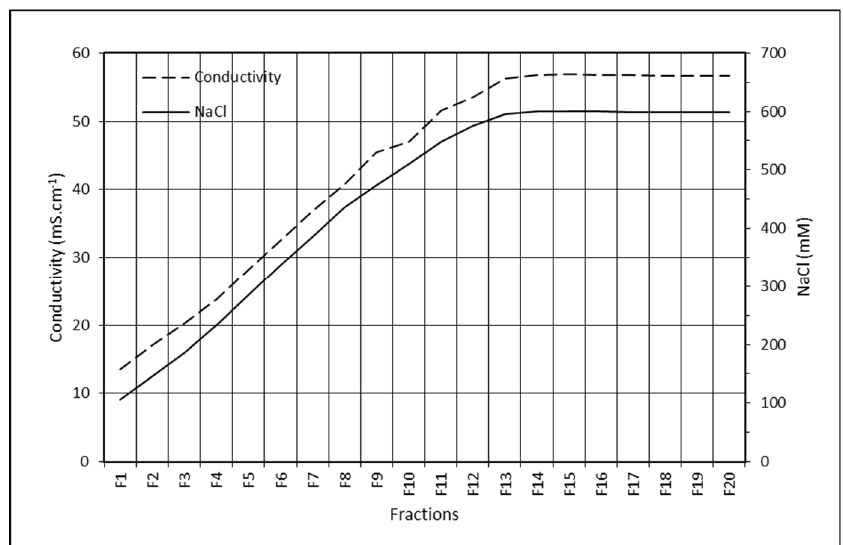
Figure 6. Relationship between Conductivity and NaCl concentration in 25 mM citrate, 5 mM CaCl 2 , pH 6.0 buffer.